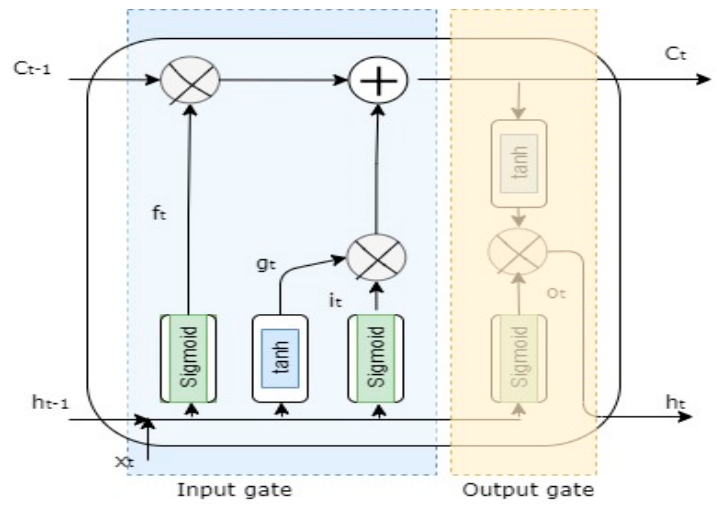
Figure 1. The original LSTM [20] .